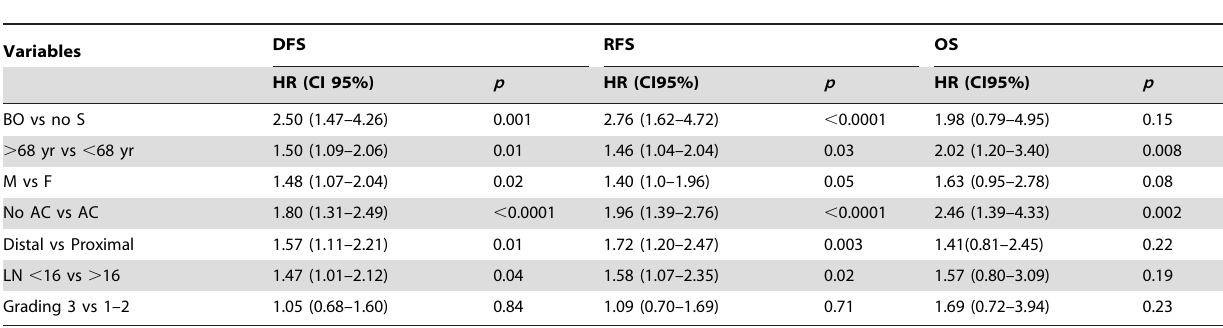
Table 2. Univariate